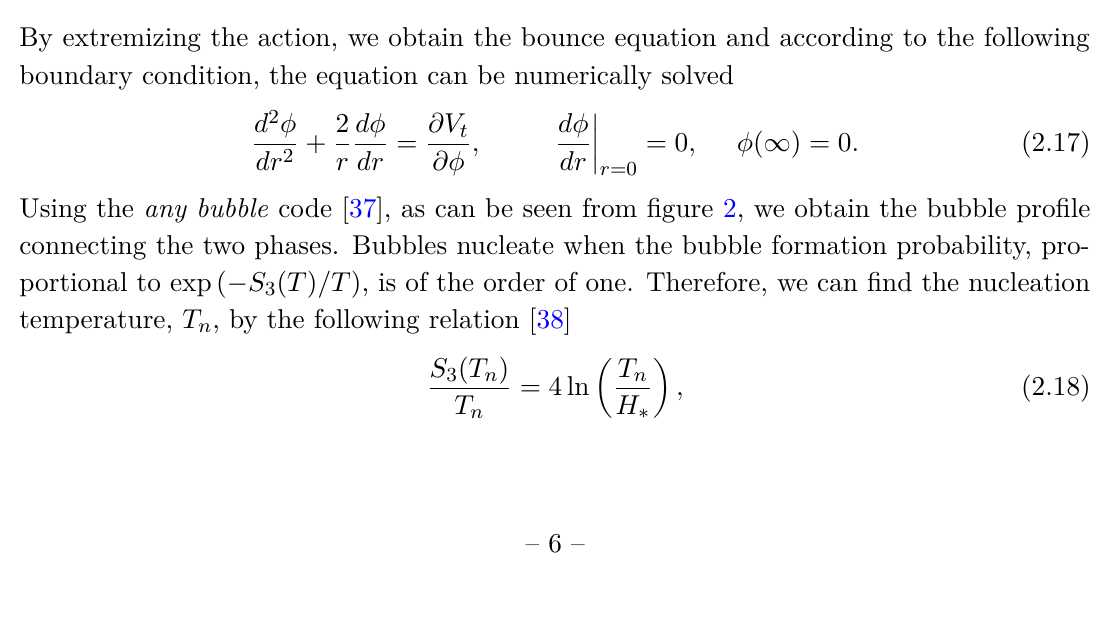
Figure 2 . The bubble profile as the solution of the bounce equation is shown. l w denotes the wall